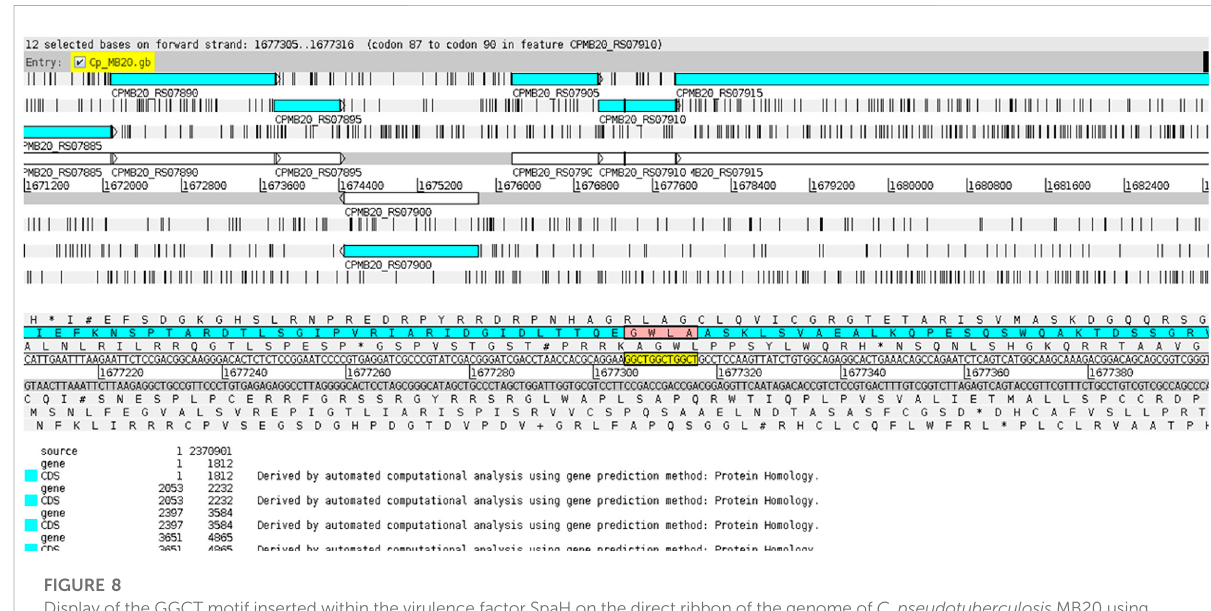
FIGURE 8 Display of the GGCT motif inserted within the virulence factor SpaH on the direct ribbon of the genome of C. pseudotuberculosis MB20 using the Artemis genome browser (Carver et al.,